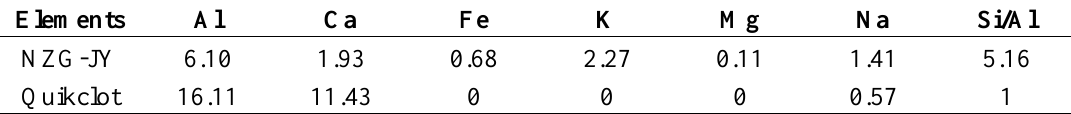
Table 2. The element composition (wt %) and Si/Al molar ratio of NZG-JY and Quikclot.